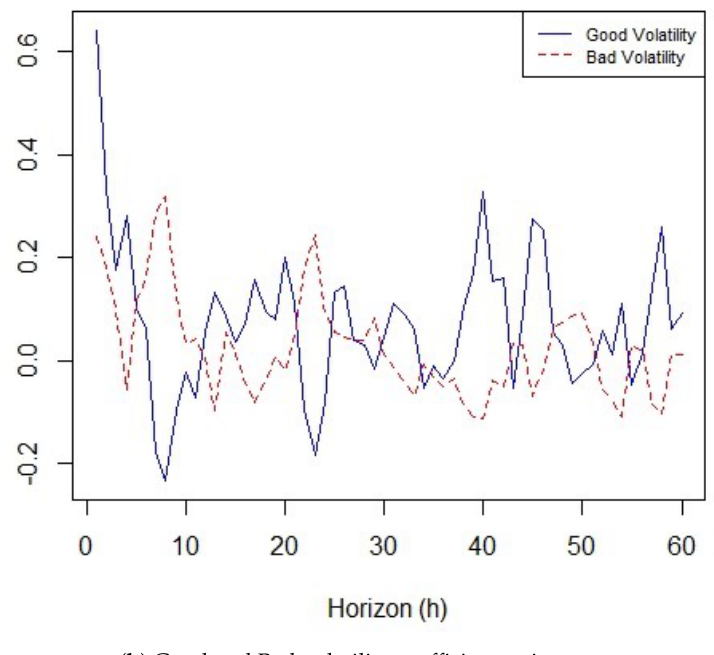
Figure 9. Predictive power and volatility asymmetry over range of forecast horizons based on Model